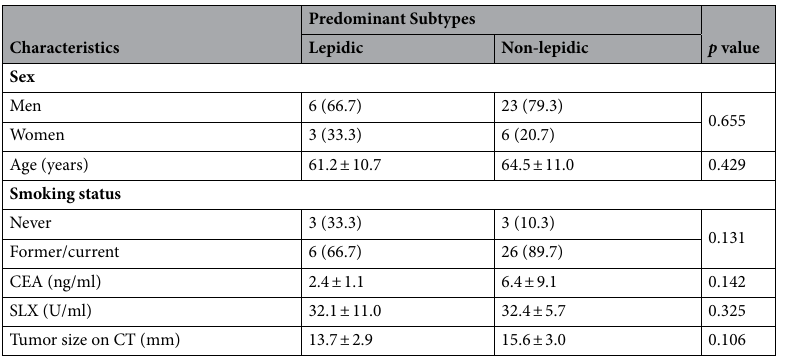
Table 3. Comparison of clinical and radiological characteristics between lepidic predominant and non-lepidic predominant lesions. Categorical variables are shown as numbers (%). Continuous variables are presented